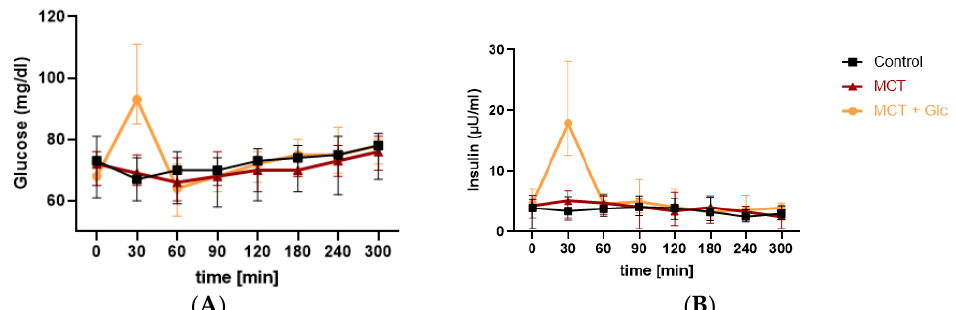
Figure 4. Median (IQR) glucose and insulin levels: ( A ) glucose levels (mg/dl) throughout the 5 h test day; ( B ) insulin levels (µU/mL) throughout the 5 h test day.